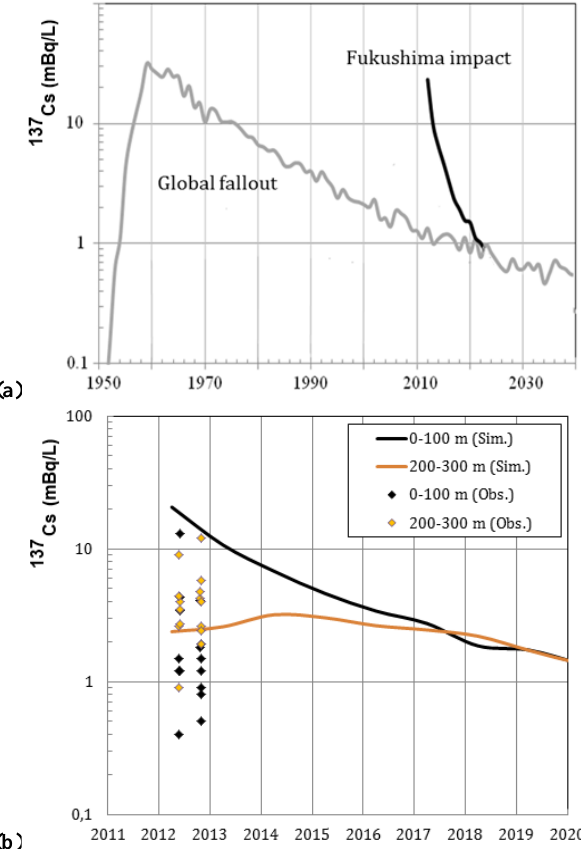
Fig. 8. (a) A comparison of simulated 137 Cs activity concentra- 8b tions of Fukushima origin in surface seawater in the NW Pacific Ocean (at 38 ◦ N, 164 ◦ E) with global fallout data (after Nakano and Povinec, 2003a) (top). (b) A comparison of simulated and ob- served 137 Cs levels in surface water (0–100m) and at 200–300m water depth with time (bottom). The seawater samples were col- lected along the 144 ◦ E line offshore Fukushima (Aoyama et al., 2013). The global fallout background (1mBqL − 1 ) has already been deducted from the experimental